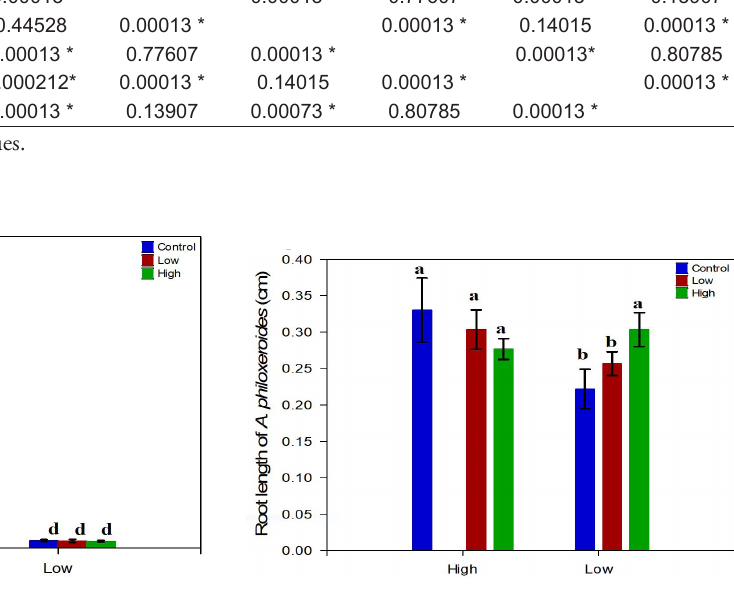
Figure 4. Root length of Alternanthera philoxeroides according to the density of neighbor specie (H density or Ldensity), the level of nutrients (H nutrient or Lnutrient) and the treatment control.